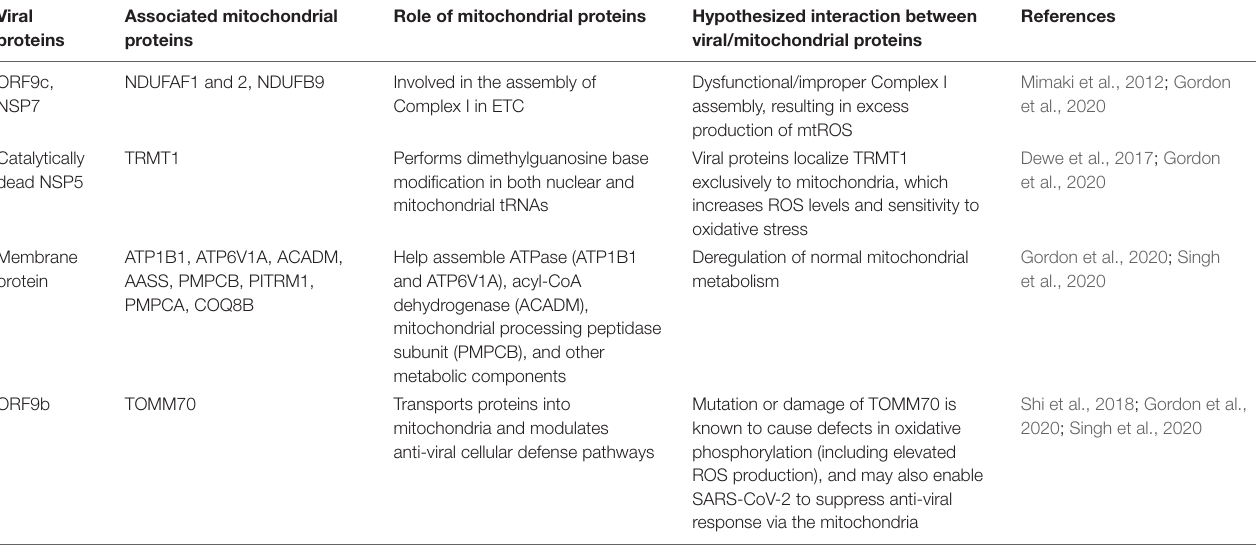
TABLE 2 | SARS-CoV-2 and mitochondrial protein